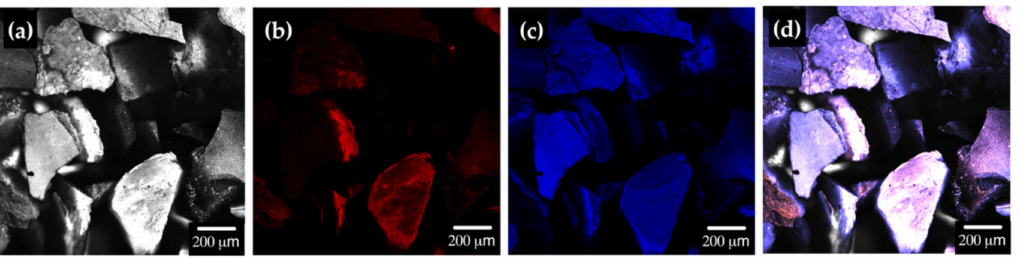
Figure 7. Optical ( a ) and confocal micrographs of native CS at 519 nm ( b ) and 461 nm ( c ). Overlay image of native CS ( d ).